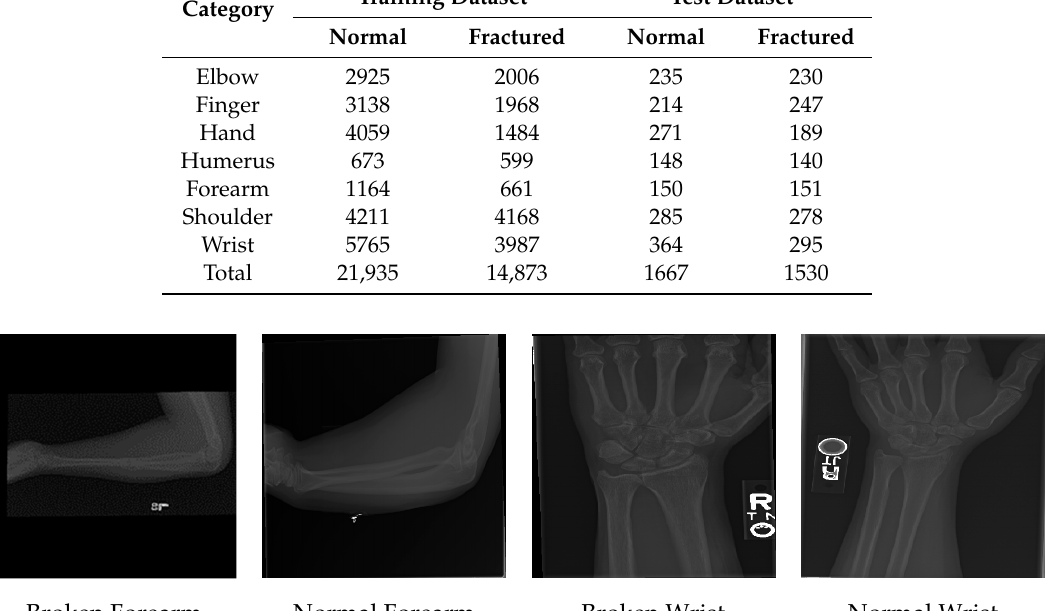
Figure 1. A sample of the MURA dataset.